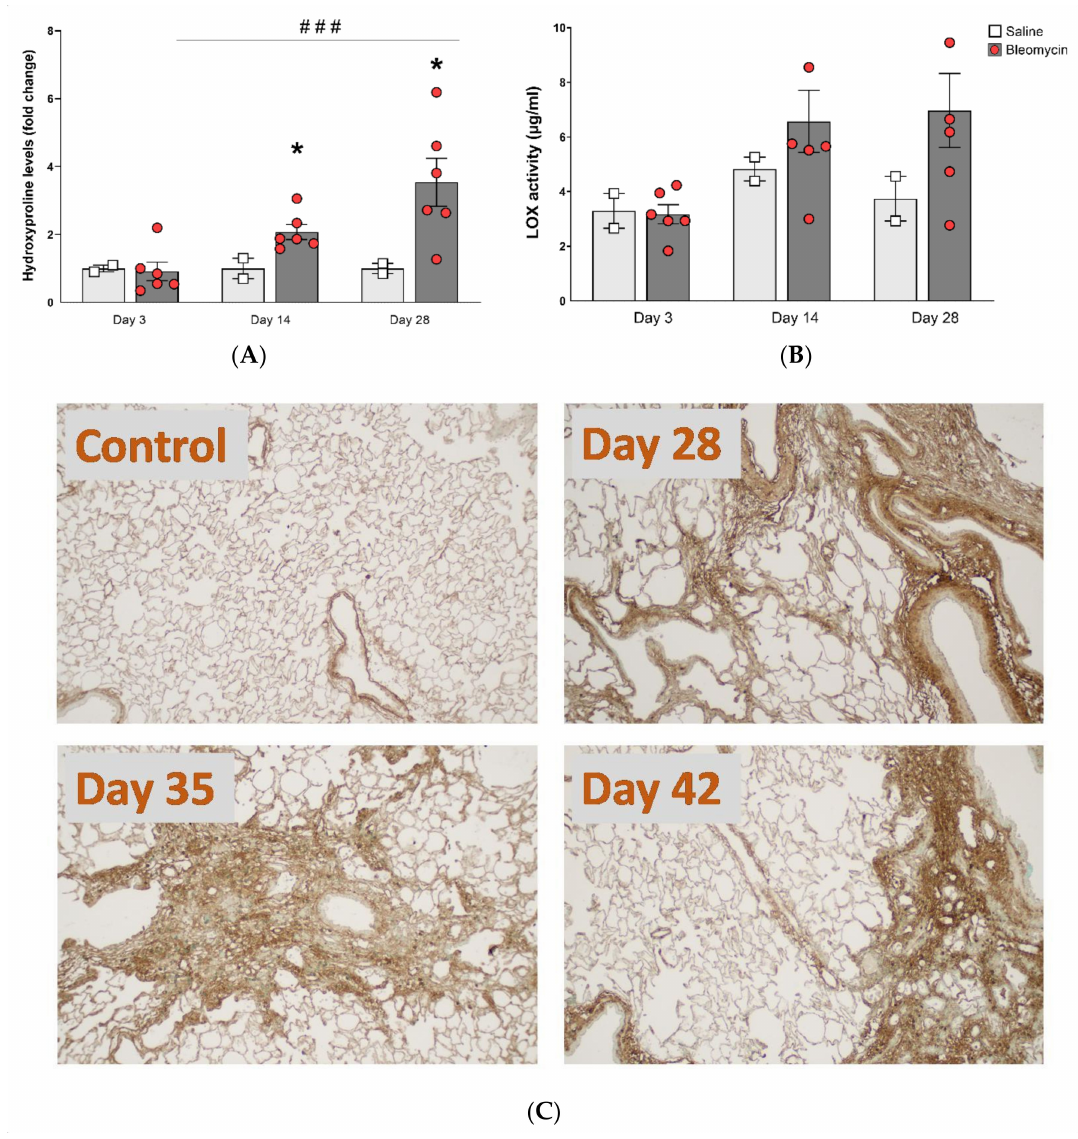
Figure 5. Collagen content and cross-linking activity. ( A ) Hydroxyproline content and ( B ) LOX activity, both increased in bleomycin challenged lungs compared to controls, and continued to increase over time. ( C ) Immunohistochemically stained tissue sections were acquired using Collagen-I antibody and representative images from three di ff erent time points are